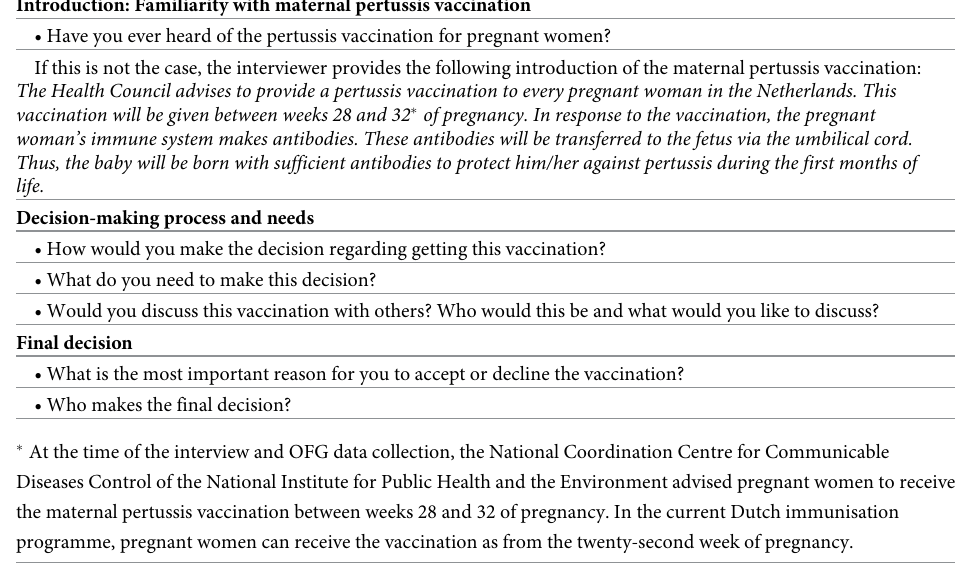
Table 1. Interview topic